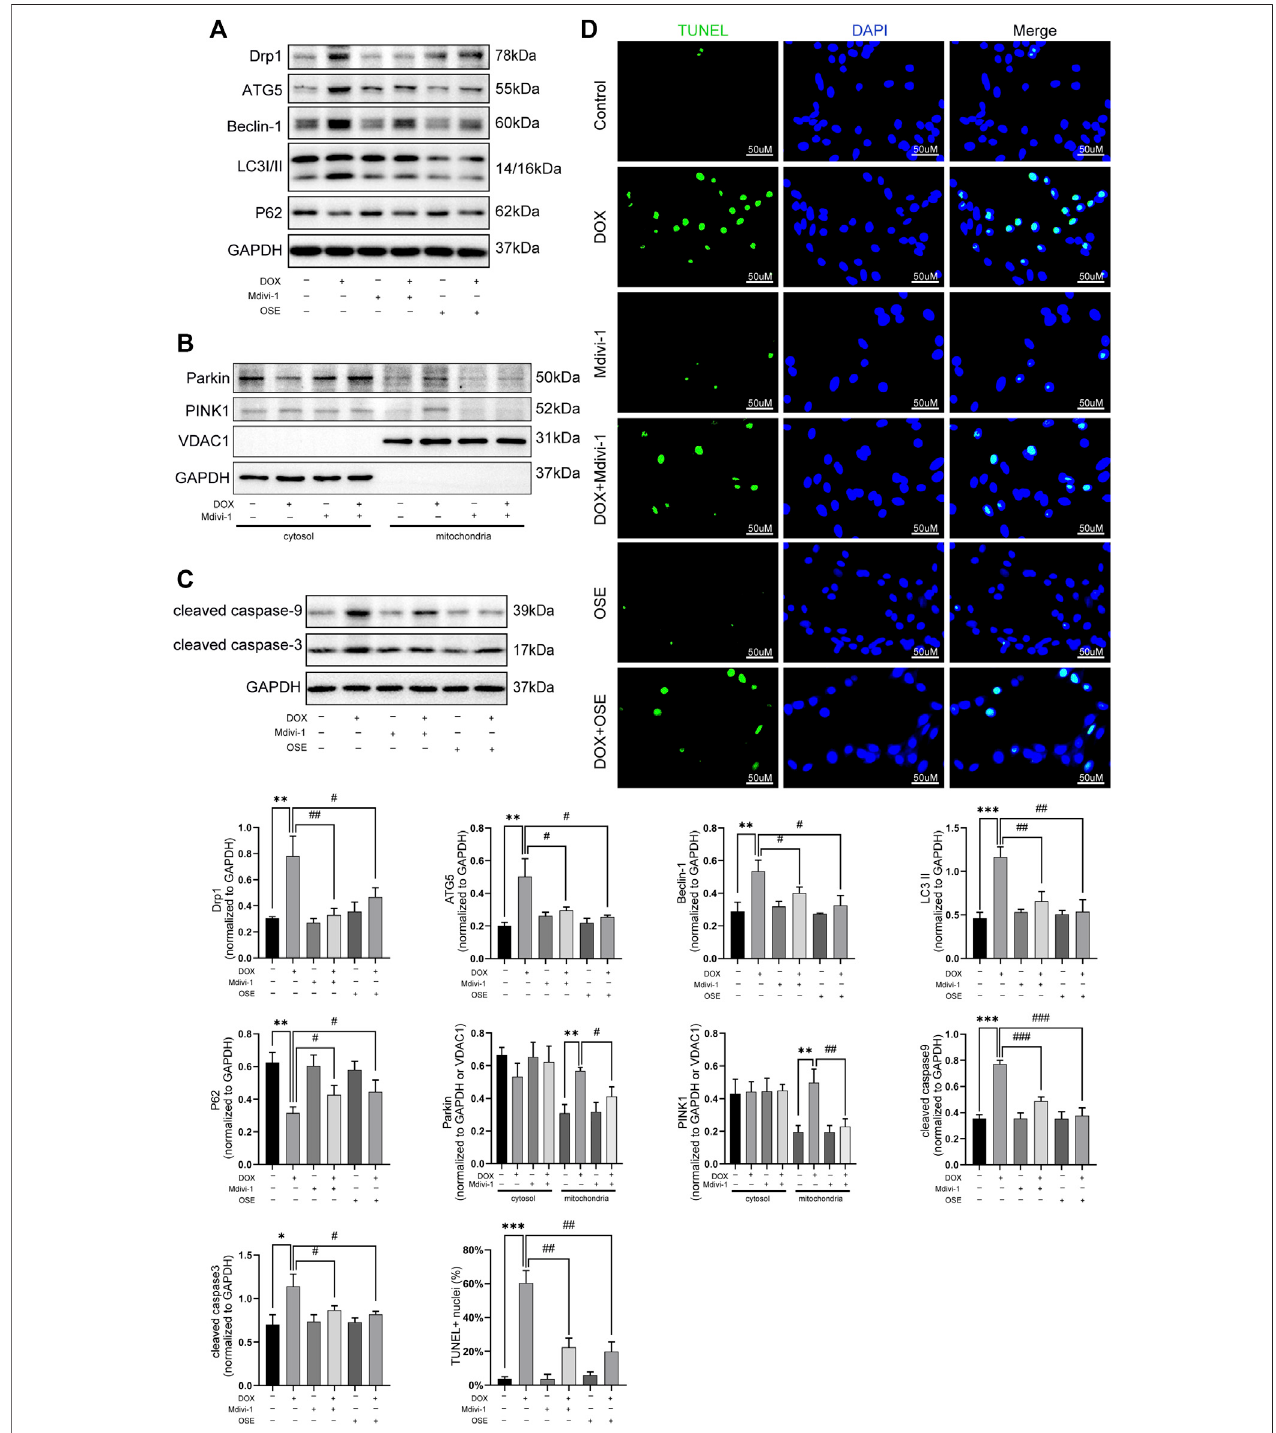
FIGURE 7 | Drp1 inhibitor Mdivi-1 showed similar effects with OSE in DOX-exposed H9C2 cells. (A) Mdivi-1 decreased the elevated Drp1 expression and suppressed the enhanced autophagic activity in DOX-treated H9C2 cells, similarly like OSE. (B) Mdivi-1 reduced PINK1 accumulation on mitochondria and prevent Parkin translocation from cytosol to mitochondria in DOX-induced H9C2 cells. (C) Consistent with the effects of OSE, Mdivi-1 suppressed apoptotic activity in DOX- induced H9C2 cells. (D) Representative TUNEL staining images showing that Mdivi-1 suppressed the enhanced apoptosis in DOX-induced H9C2 cells, similarly like OSE.